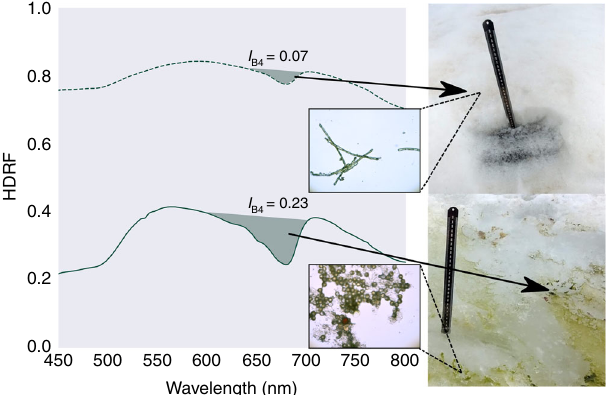
Fig. 2 Snow algae re fl ectance factors. Hemispherical directional re fl ectance factors (HDRFs) of green snow algae, showing representative spectra from high (solid, green line) and low (dashed, green line) cell density patches of snow algae with corresponding I B4 , sampling site photograph and bright fi eld microscope image (black scale bar represents 5 μ m). HDRFs, photographs and microscopy from snow sampled close to Refugio Collins, King George Island, Antarctica.